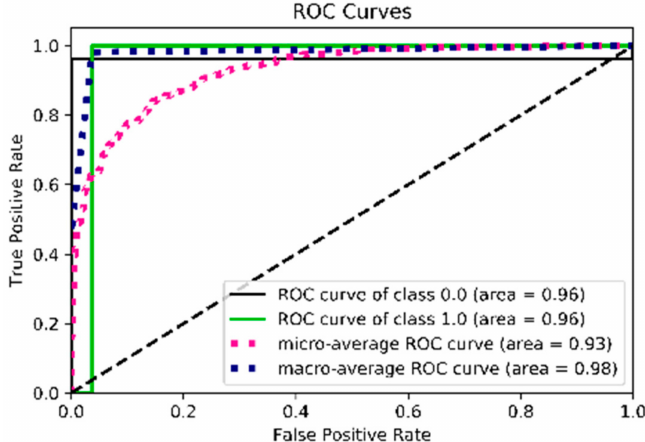
Figure 17. Receiver operating characteristic (ROC) curves of landslide susceptibility map.